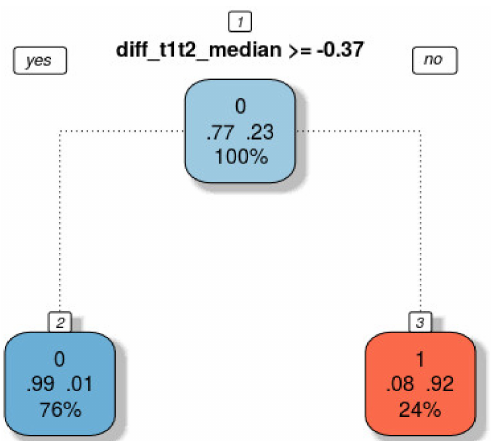
Figure 12. Rules tree of the Recursive Partitioning approach for the binary classification of building structures to two classes: 1—Demolished (red) and 0—Non-Demolished